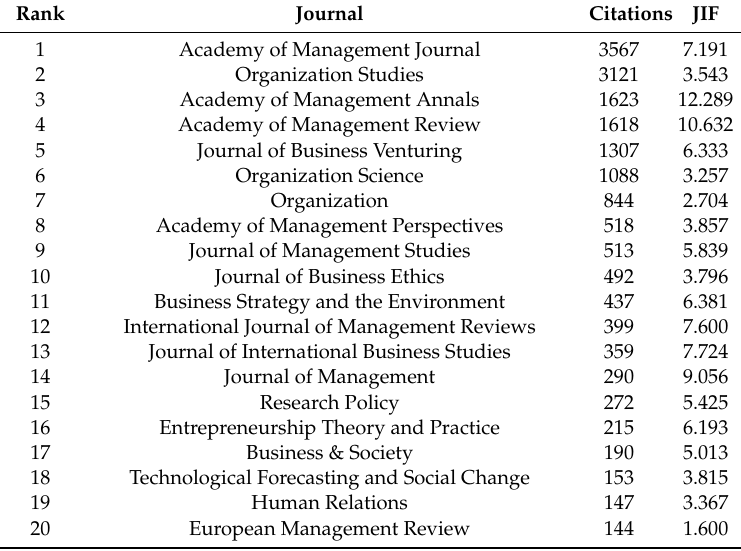
Table 4. Journal